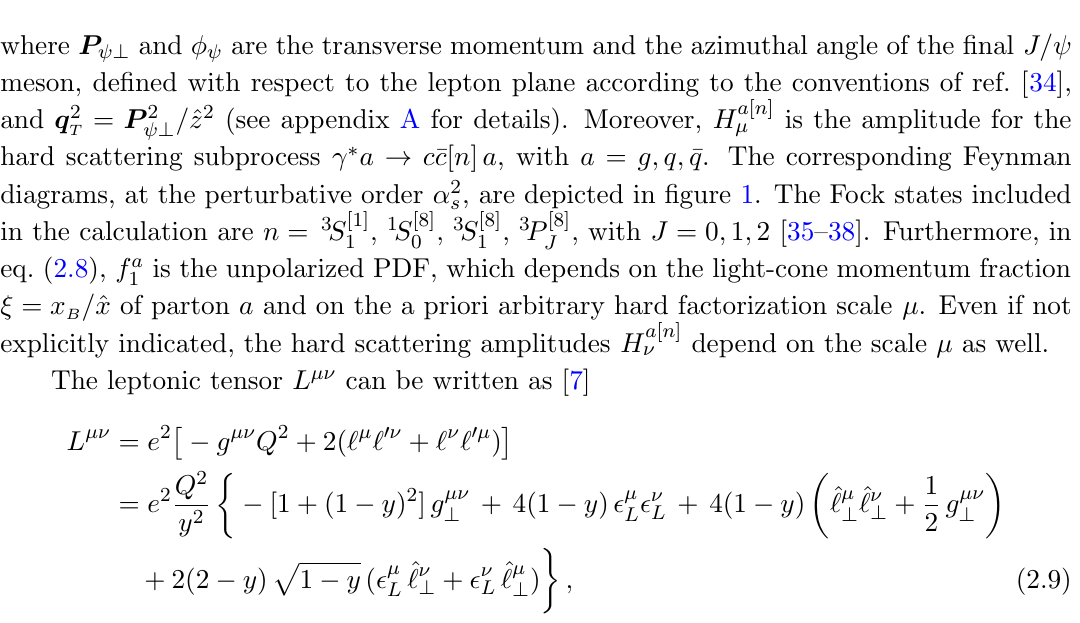
Figure 1. Representative diagrams for the partonic process (cid:13) with a = g; q; (cid:22) q at the order (cid:11) 2 are of the type (a), and there are six of them. There are two diagrams for each type (b), (c), (d). The dominant diagrams in the small- q